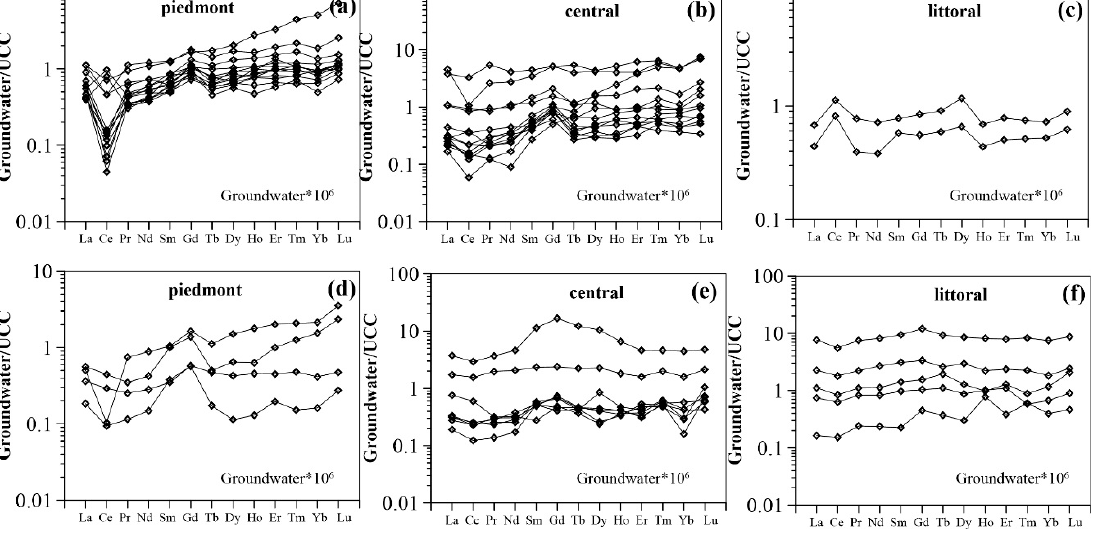
Figure 4. Upper continental crust (UCC)-normalized rare earth elements (REE) patterns for groundwater samples from three zones. (( a ), ( b ), ( c ): shallow groundwater samples; ( d ), ( e ), ( f ): deep groundwater samples).